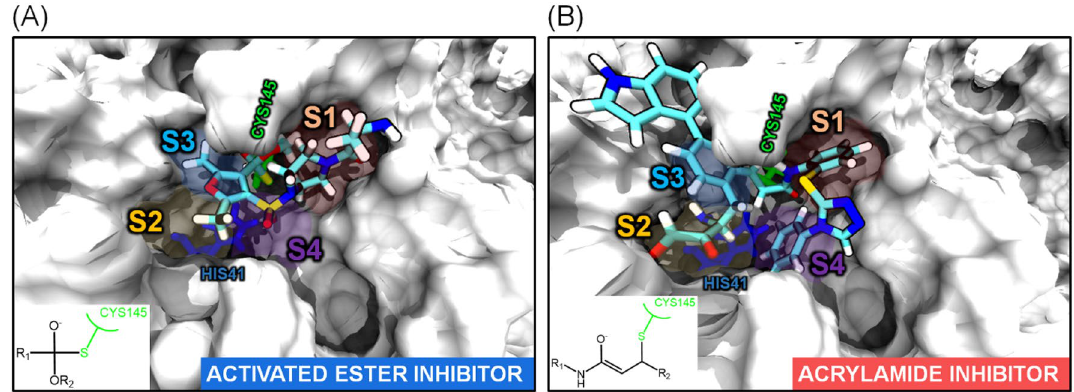
Figure 3. Observed binding modes of covalently bound ( A ) ester and ( B ) acrylamide warheads following electrophilic attack at CYS145 of M PRO . Blue, cyan, red, yellow, and white licorice representations denote nitrogen, carbon, oxygen, sulfur, and hydrogen atoms respectively. S1–S4 binding pockets are represented by orange, yellow, blue, and purple shadows,